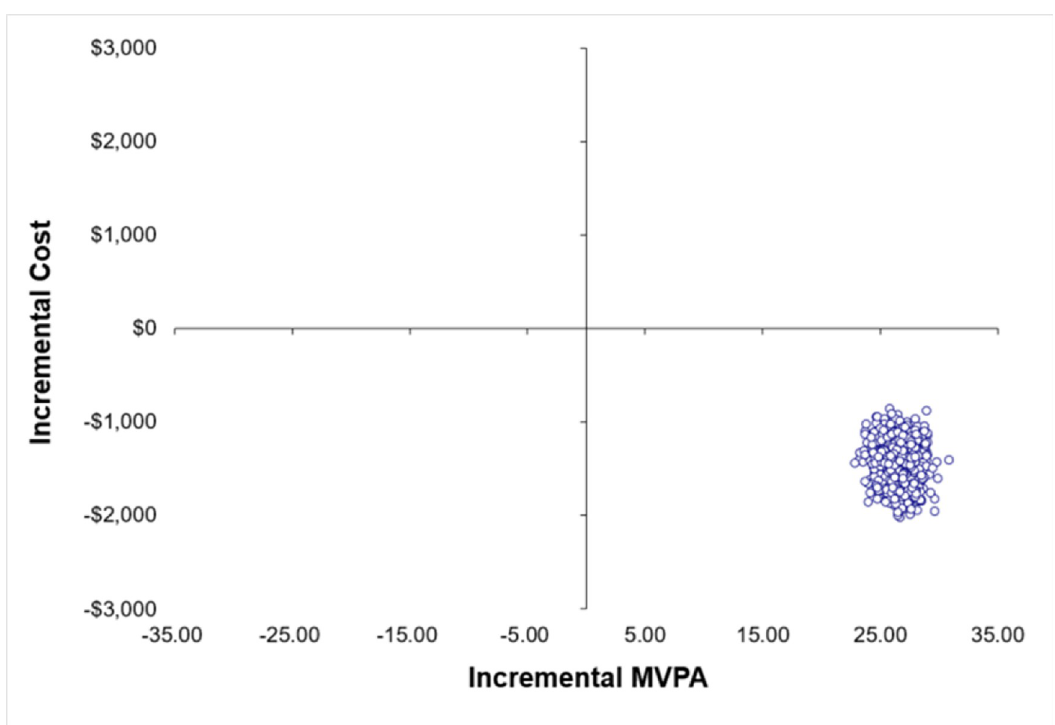
Fig 2. Incremental cost-effect pairs from 1000 bootstrap resamples for MVPA change.